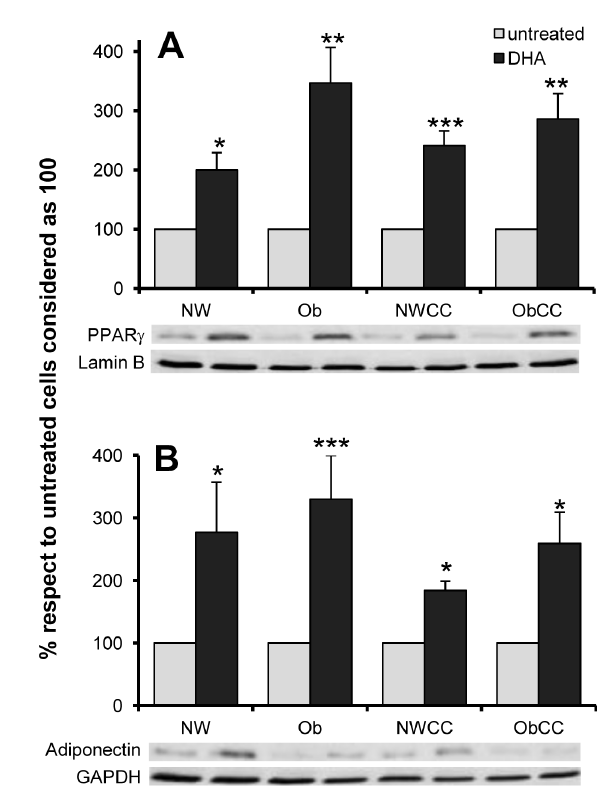
Figure 5. Immunoblotting analysis of PPARγ, and adiponectin after DHA treatment. Human visceral adipocytes, collected from the four groups of subjects, were serum-starved for 18 h and incubated with 10µM DHA, as described in Material and Methods. Nuclear protein extracts and whole cell extracts were separated by SDS-PAGE and analyzed using anti-PPARγ ( A ) and anti-adiponectin ( B ) antibodies. Results were normalized to Lamin B and GAPDH protein content, respectively. NW: normal weight subjects (n=5); Ob: overweight/obese subjects (n=5); NWCC: normal weight with colorectal cancer (n=7); ObCC: overweight/obese with colorectal cancer (n=7). The data are expressed as means ± SEM. *, P<0.05; **, P<0.01; ***, P<0.01 compared with untreated paired cells. Representative blots are